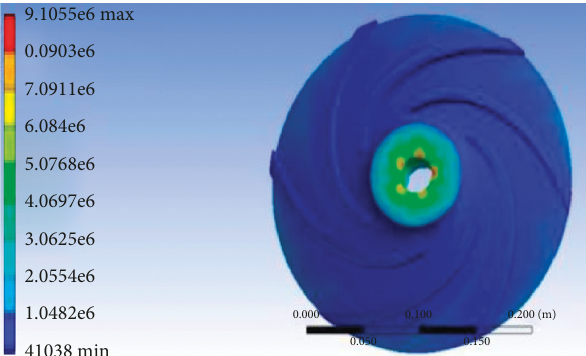
Figure 16: Stress distribution diagram after